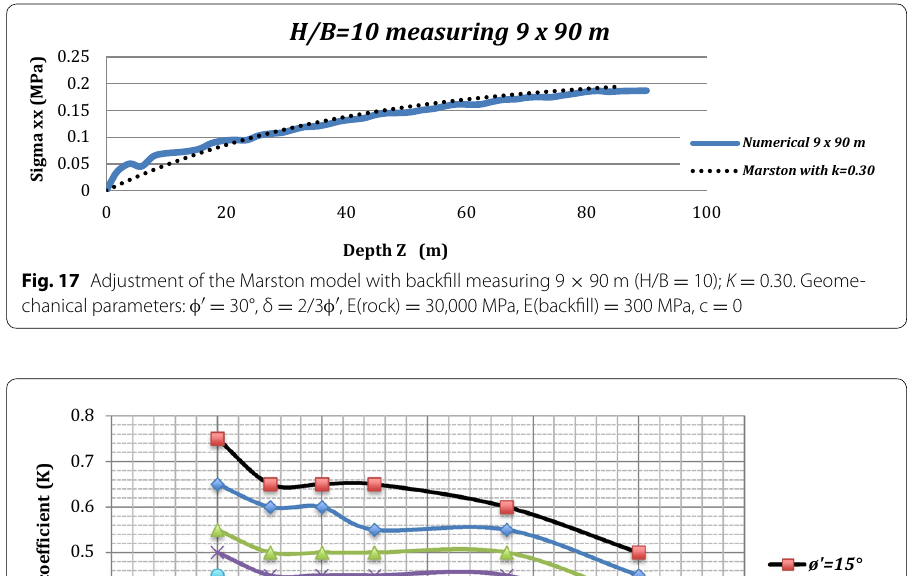
30°, δ 2/3 φ ′ , E(rock) = =